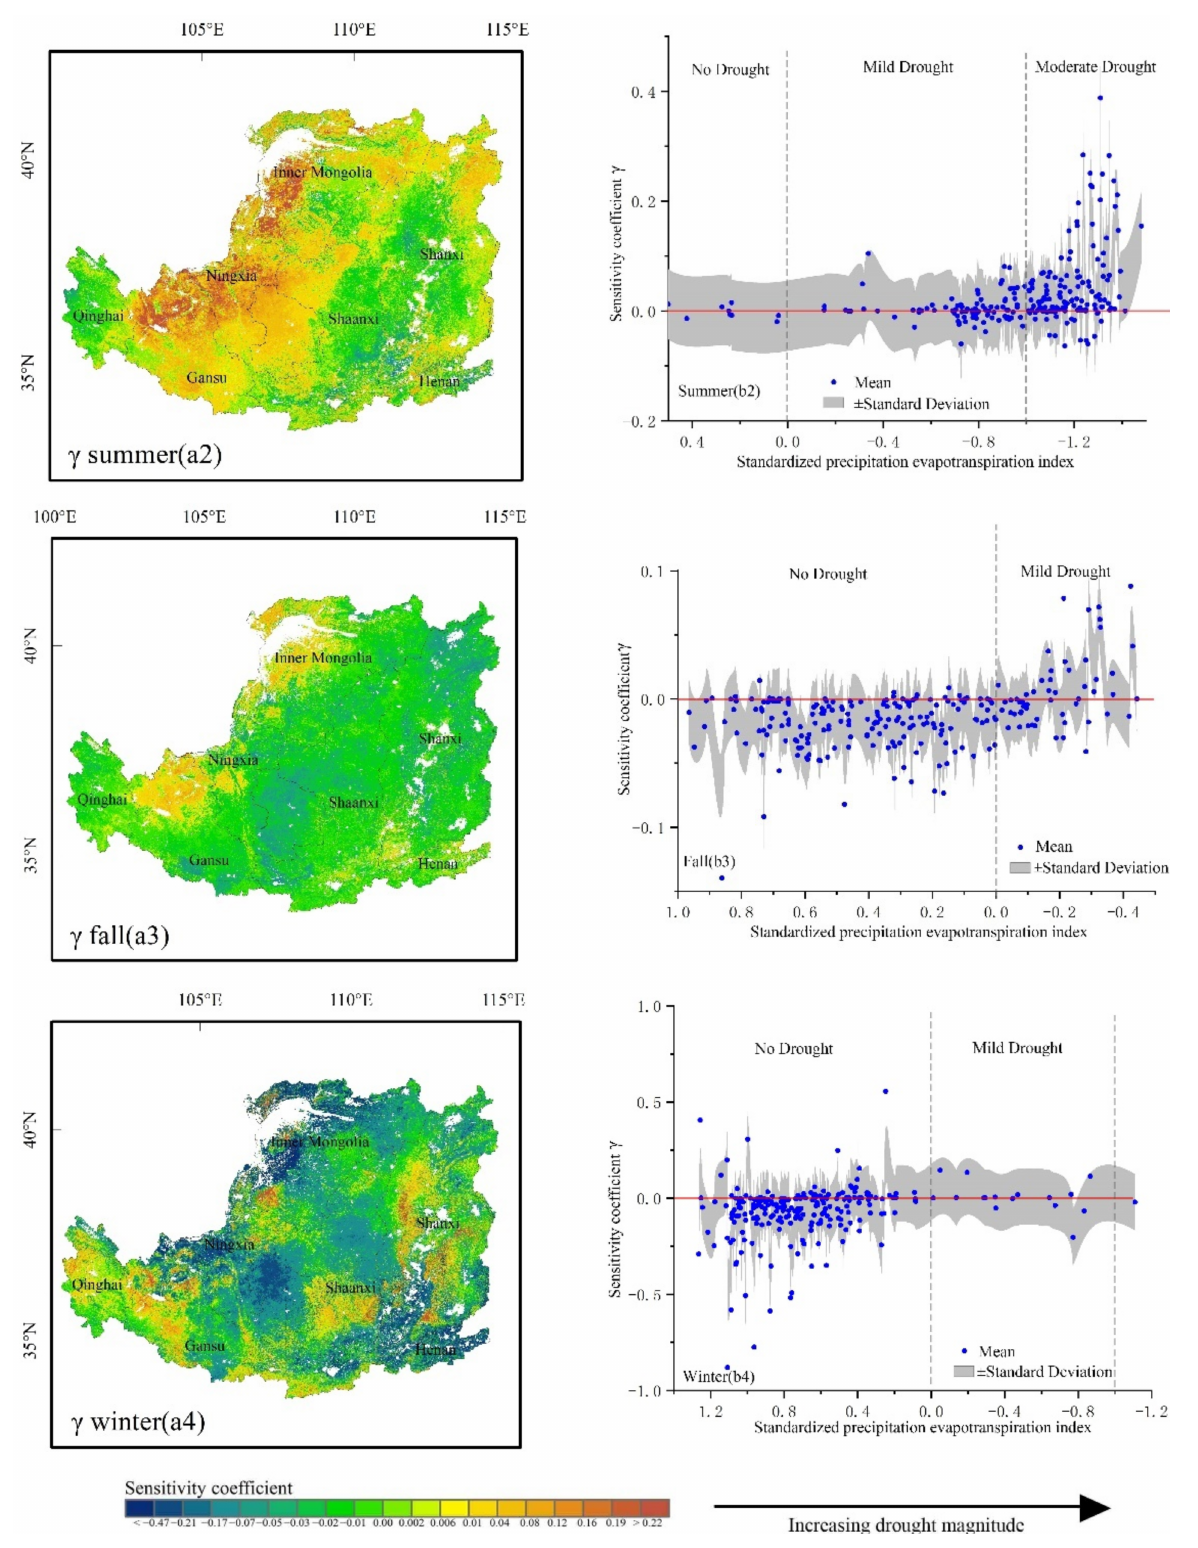
Figure 5. Spatial distribution of the sensitivity coefficient( γ ) of water-use efficiency (WUE) to seasonal drought (SPEI) ( a1 – a4 ) and scatter plot of the change in WUE sensitivity of each season in relation to the magnitude of drought ( b1 – b4